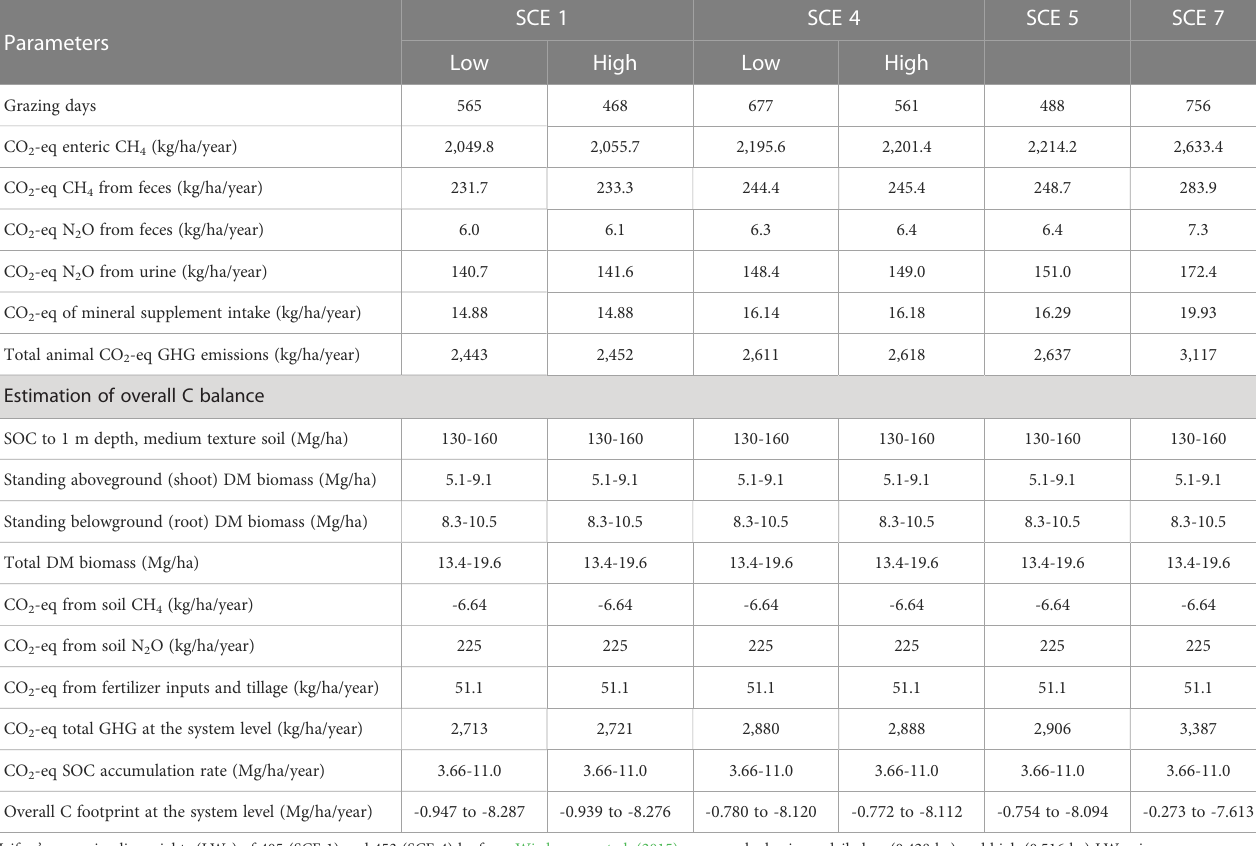
TABLE 6 Estimated greenhouse gas (GHG) emissions and overall carbon balance in young Brahman ( Bos indicus ) heifers and steers grazing on Brachiaria decumbens pastures across weaning-fattening systems characterised by contrasting liveweight (LW) processing scenarios (SCEs).